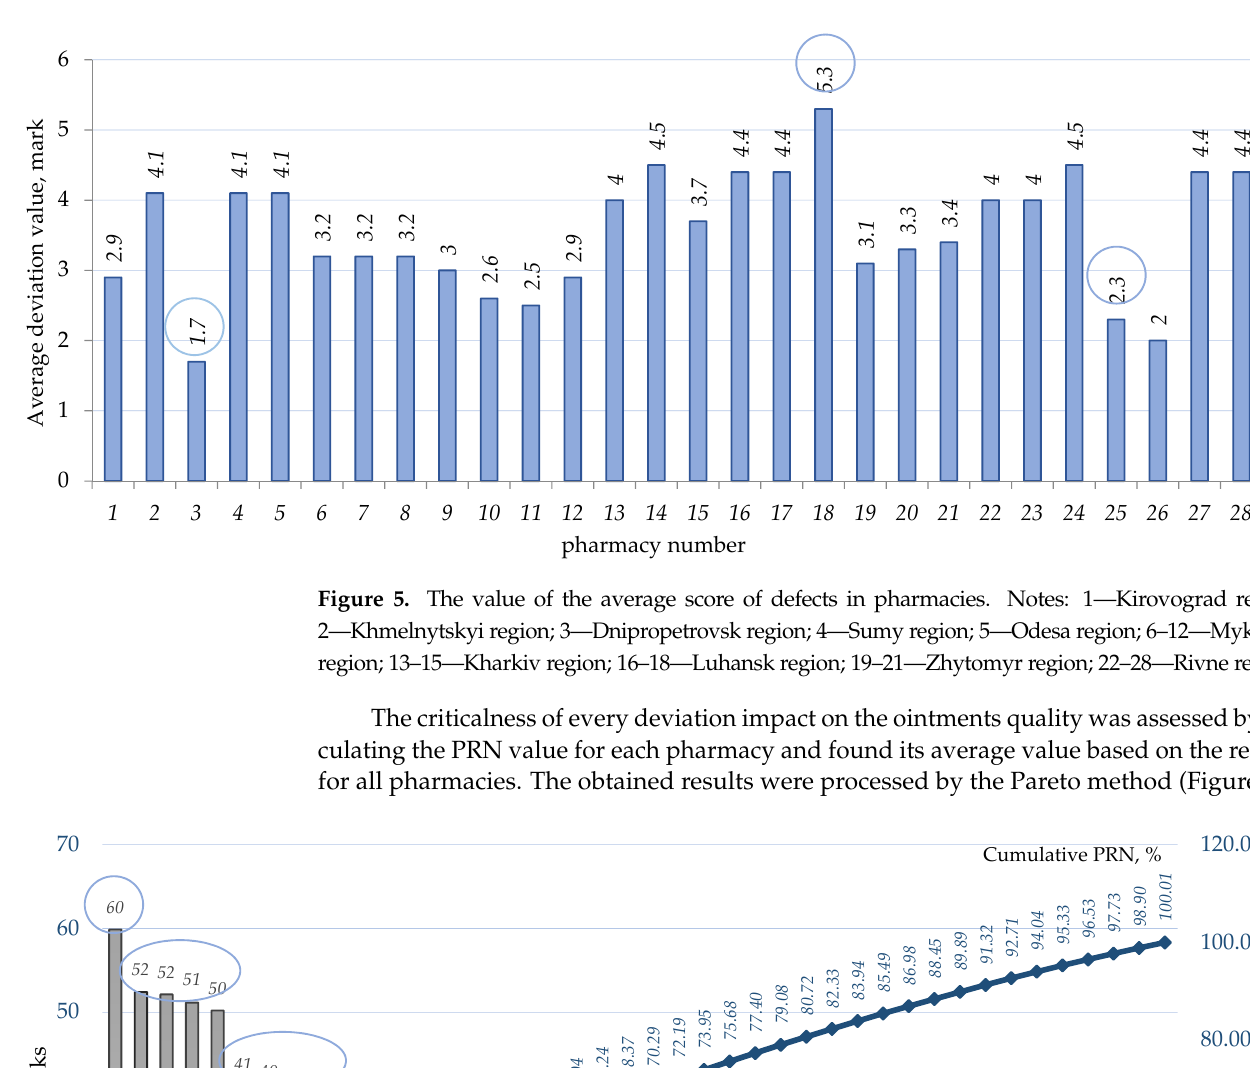
Figure 4. Percentage of each region’s participation in the survey (by the pharmacies quantity). For the estimation of functioning and the effectiveness of QAS implementation in pharmacies, the average mark of the risks assessment values for each compounding phar- macy that participated in the study was calculated (Figure 5).